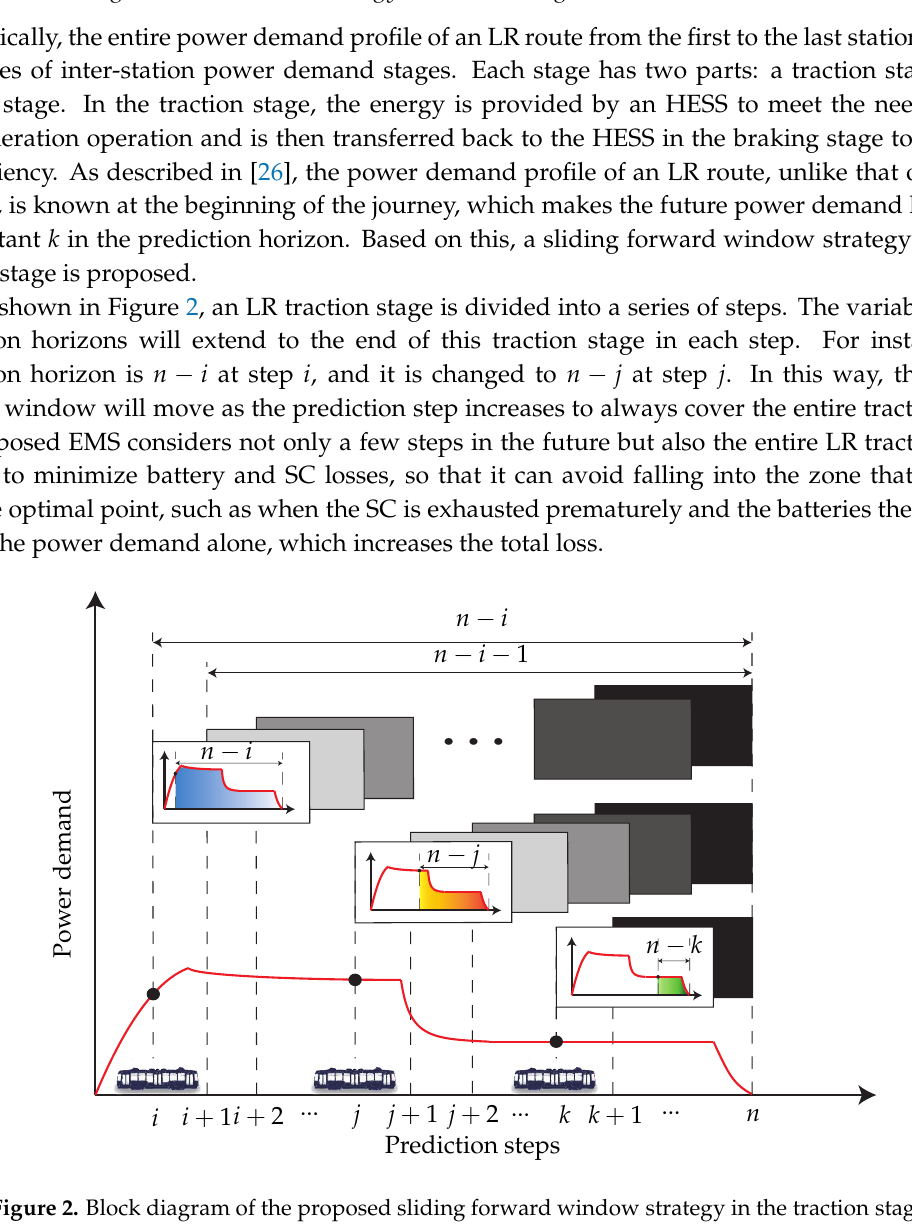
Figure 2. Block diagram of the proposed sliding forward window strategy in the traction